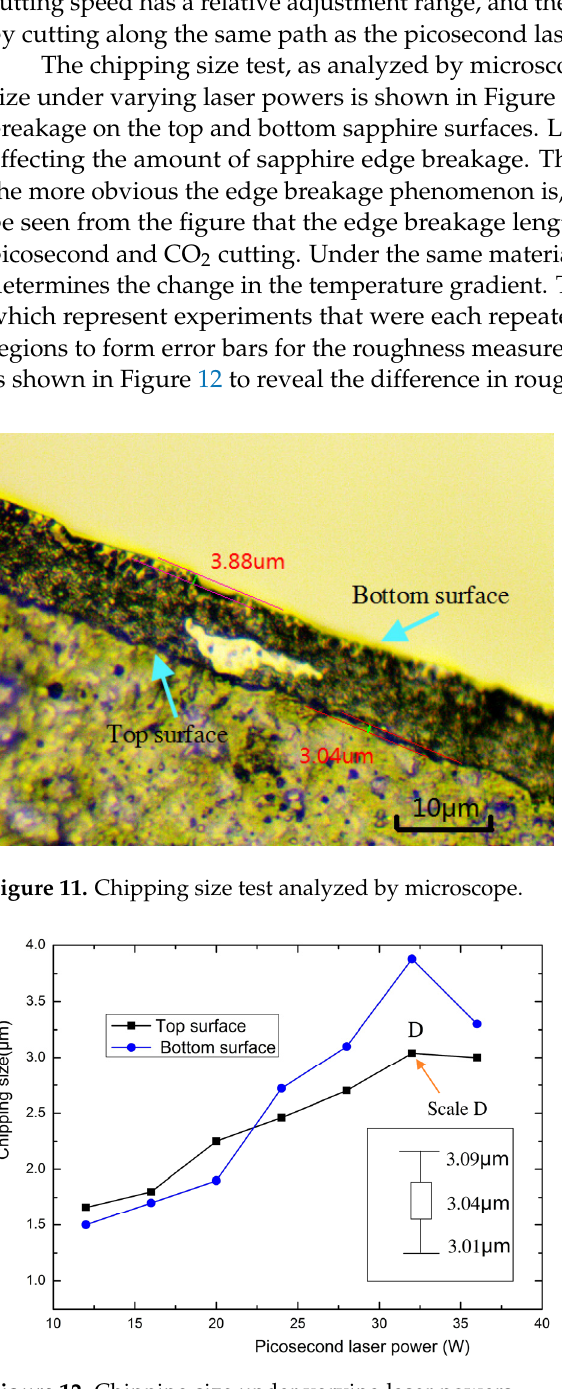
Figure 12. Chipping size under varying laser powers.